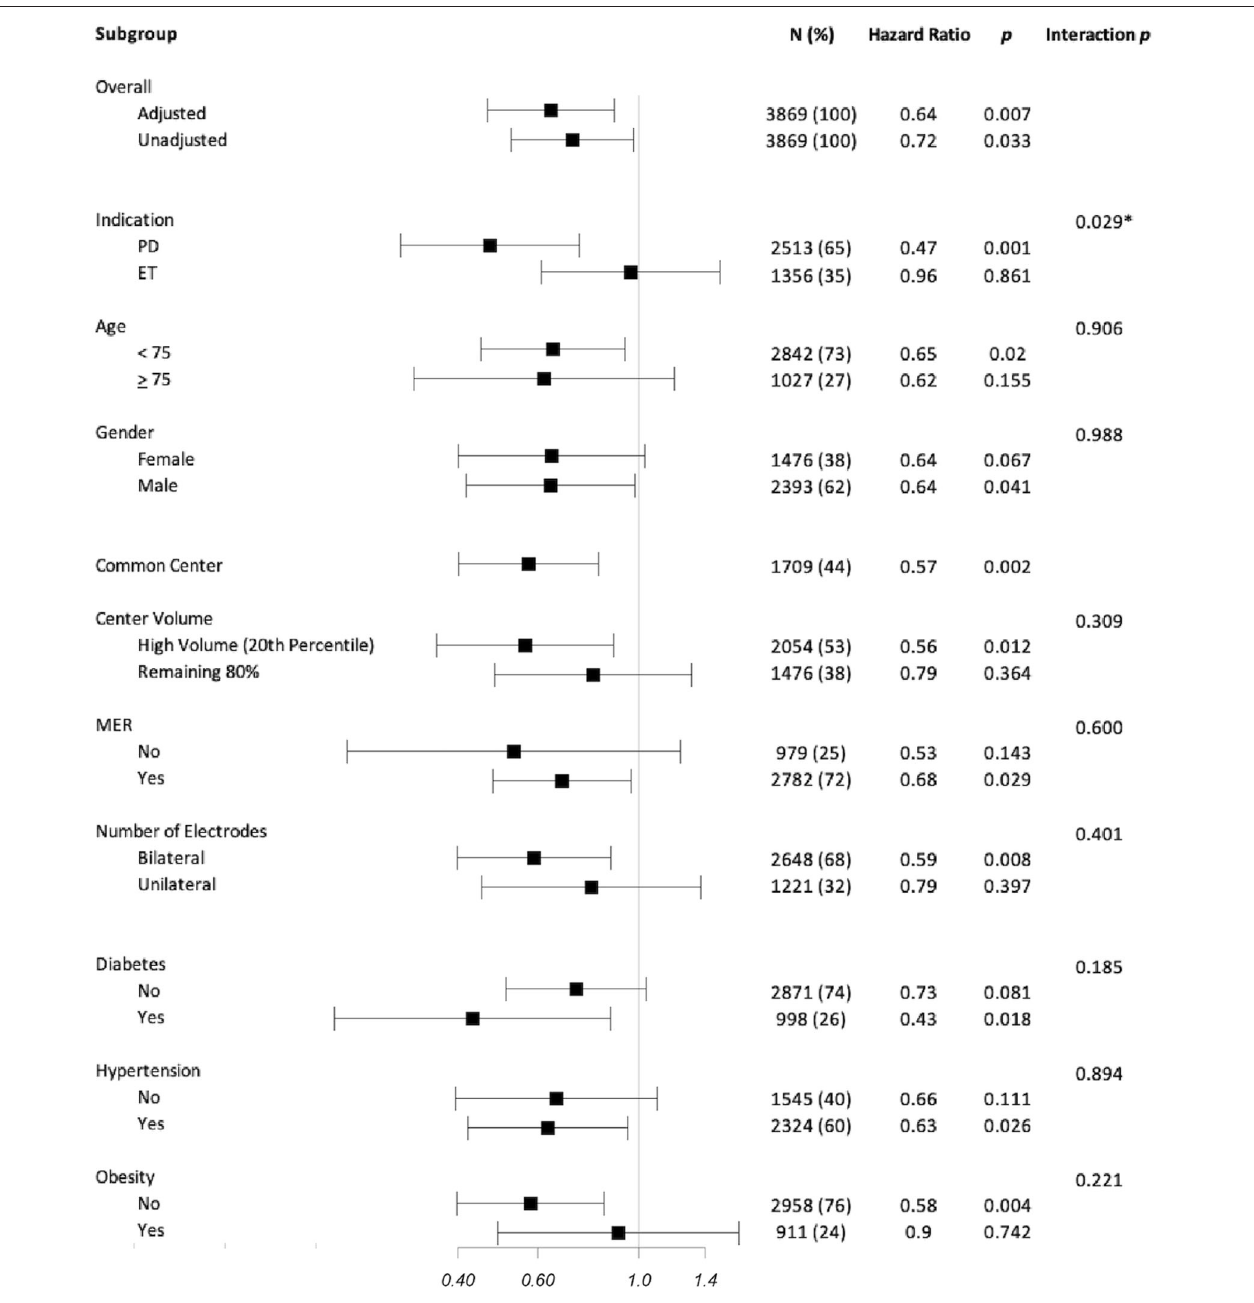
FIGURE 3 | Subgroup analysis of hazard ratio (HR) for event-free survival from lead or implantable pulse generator reoperations. HRs are represented as squares with 95% CI bars. HRs < 1 represents a reduced risk associated with modern directional systems. Columns show the number of subjects included in the subgroup analysis is reported for each analysis; the equivalent percentage of the entire cohort that this subgroup represents is reported in parentheses. Within the subgroup analysis, only the primary diagnosis associated with the DBS implant demonstrated a statistically significant difference (indicated by an *) with those implanted for Parkinson’s disease experiencing a notable HR reduction compared to those implanted for essential tremor. There was no significant difference when considering age, gender, center, center experience, use of MERs, number of electrodes implanted, or comorbidities of diabetes, hypertension, or obesity. implanted, did not significantly influence the risk